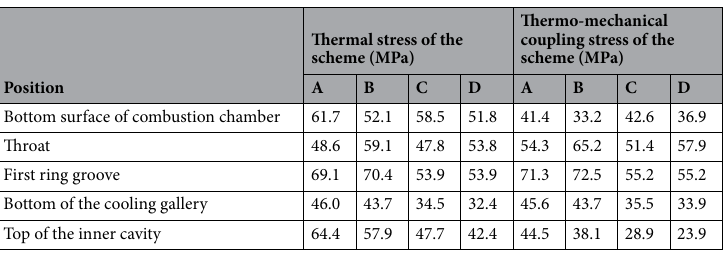
Thermal stress of the scheme (MPa)